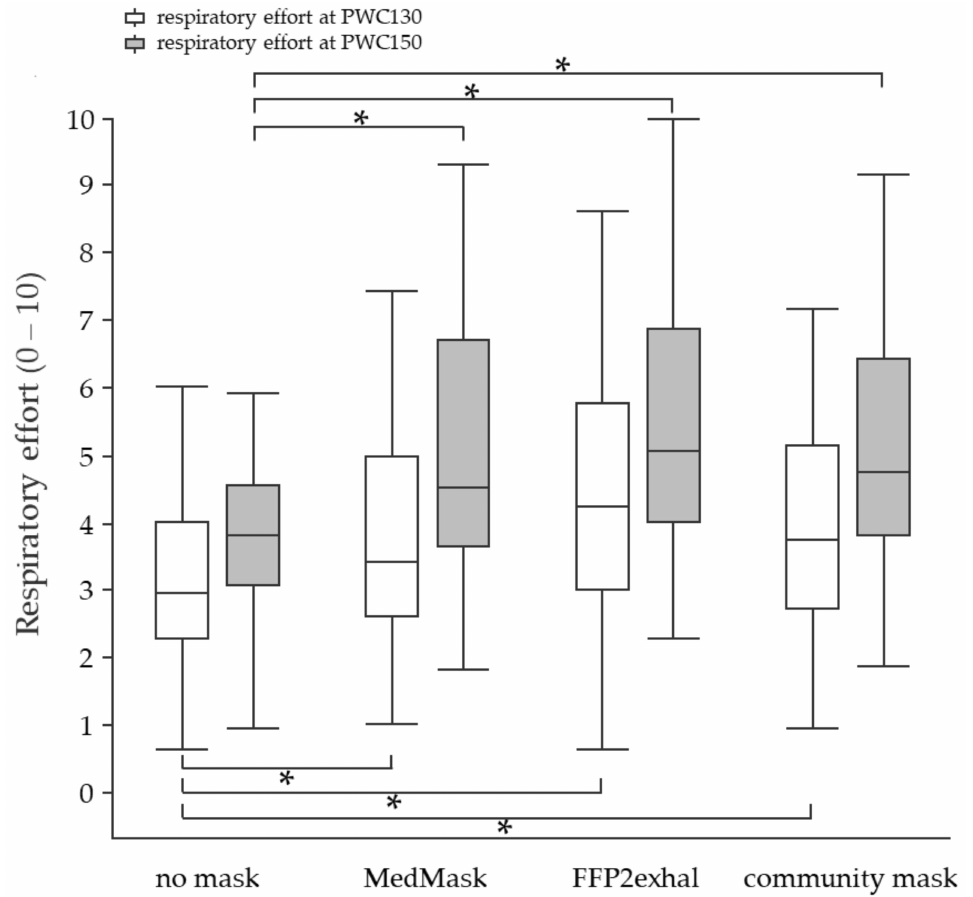
Figure 7. Perceived respiratory effort at the heart rate of 130 and 150 beats per minute using different face masks. Grey shaded boxplots represent respiratory effort at PWC150. Asterisks indicate statistically significant differences (Bonferroni corrected p < 0.003). 0 = no respiratory effort, 10 = maximum respiratory effort. PWC, physical working capacity; MedMask, medical face mask; FFP2exhal, filtering facepiece with exhalation